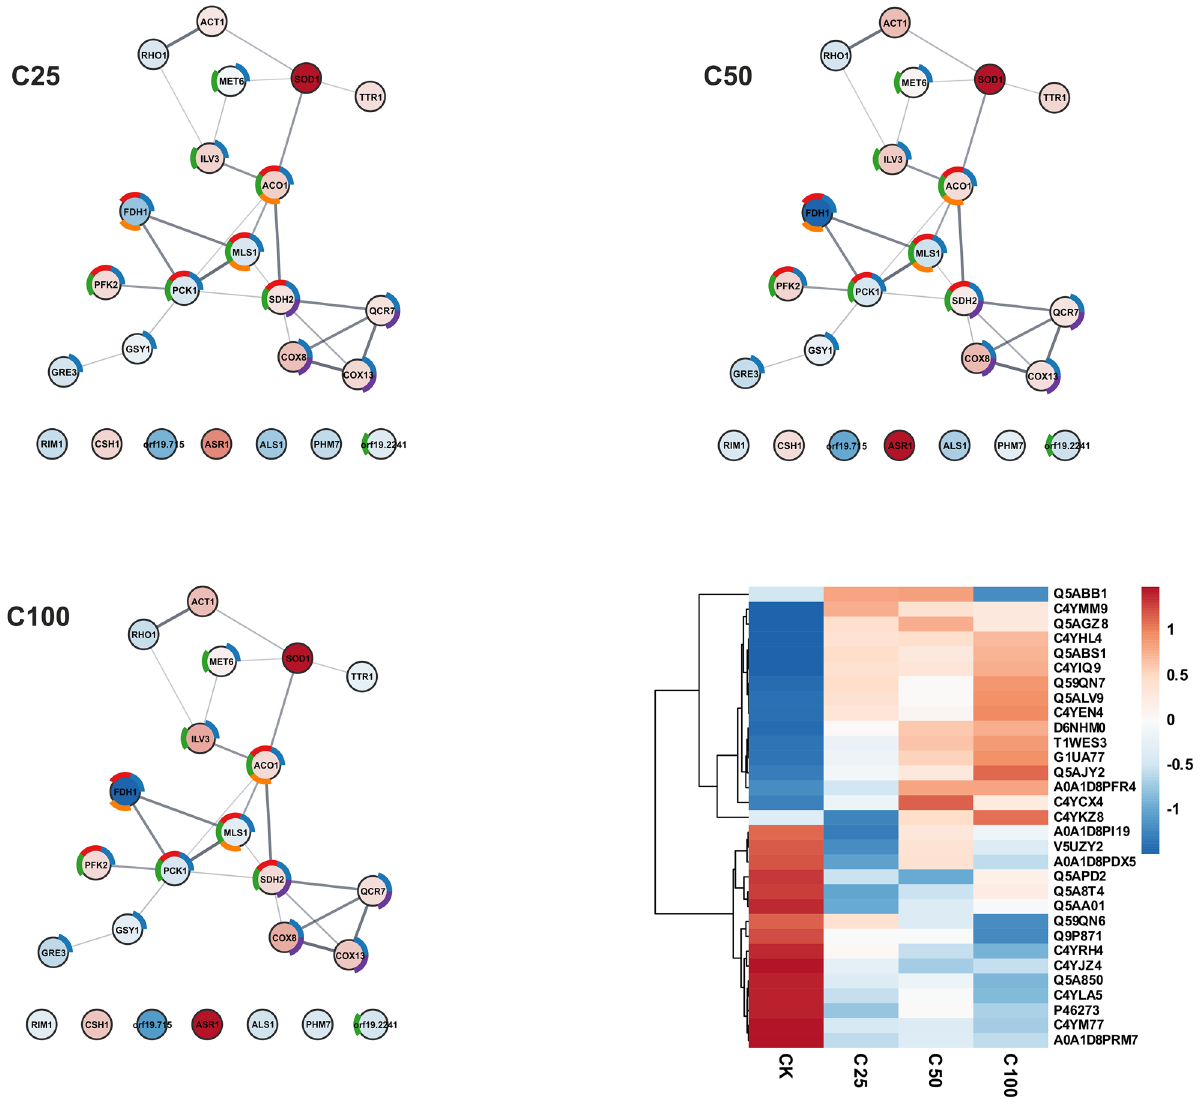
Figure 8. Graphical representation of the results of the quantitative functional analysis of the response of the C. albicans proteome to the AAF fraction. The color of the circles corresponds to fold changes: red for higher than 1, and blue for lower than 1. The color intensity indicates the size of the change. The donut chart colors correspond to KEGG pathways—blue: metabolic pathways, red: carbon metabolism, green: biosynthesis of secondary metabolites, orange: glyoxylate and dicarboxylate metabolism, purple: oxidative phosphorylation. The SWATH heatmap represents the comparison of the median of each sample with the t-test control sample (proteins with a p-value below 0.05 in each